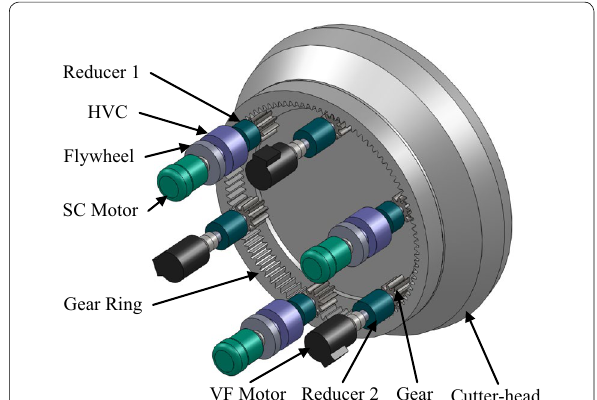
Figure 1 TBM cutter-head driving system with an HVC